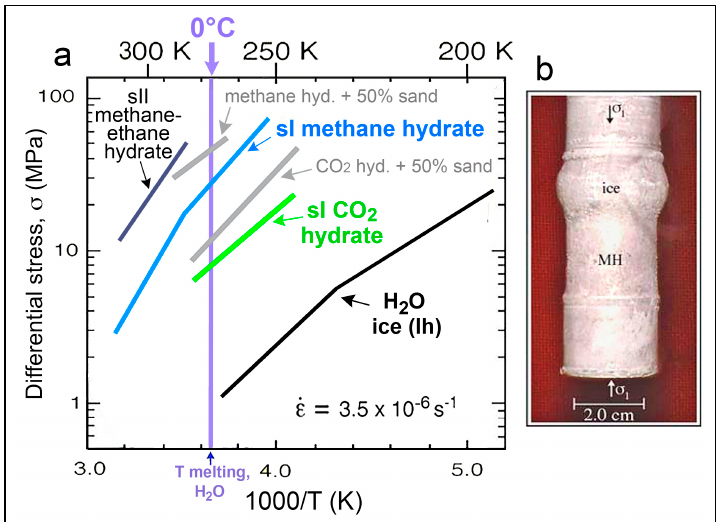
Figure 5. Rheological strength contrasts of gas hydrates and ice. ( a ) Ductile flow, plotted as log σ vs. reciprocal temperature (Arrhenius plot) of sI methane hydrate, sI CO 2 hydrate, sII methane–ethane hydrate, and H 2 O ice. Modified from Figure 4 in Durham et al. [83]. Here, σ denotes stress. Strain rate is 3.5 × 10 − 6 s − 1 . Not only are gas hydrates substantially stronger than water ice, but they can also exhibit strength contrasts amongst different structures (sI vs. sII) as well as different compositions of the same structure (sI CH 4 vs. CO 2 hydrate). Adding a uniform mix of 50 vol.% quartz sand to either CH 4 or CO 2 hydrate (gray lines) increases strength by ~2× with respect to the pure end-members. ( b ) Indium-jacketed composite sample of methane hydrate (“MH”, bottom) and ice (top) between two end caps, illustrating the manifest strength contrast whereby sample strain is accommodated by the significantly weaker ice phase (modified from Figure 1 in [82]). The sample was a near-perfect cylinder prior to testing.